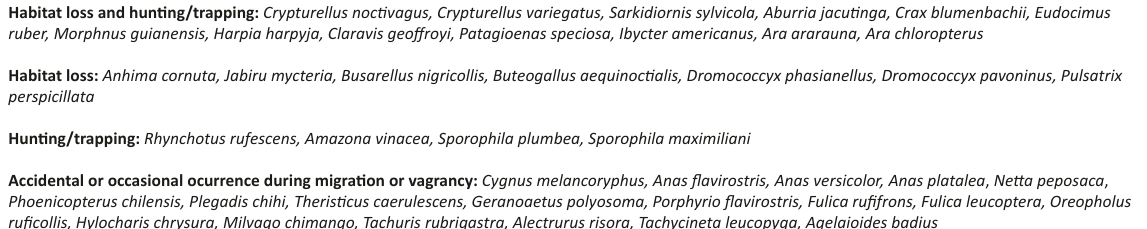
Table 5. Possible causes of local rarity for the rarest bird species in the state of Rio de Janeiro. Habitat loss and hunting/trapping: Crypturellus noctivagus, Crypturellus variegatus, Sarkidiornis sylvicola, Aburria jacutinga, Crax blumenbachii, Eudocimus ruber, Morphnus guianensis, Harpia harpyja, Claravis geoffroyi, Patagioenas speciosa, Ibycter americanus, Ara ararauna, Ara chloropterus Habitat loss: Anhima cornuta, Jabiru mycteria, Busarellus nigricollis, Buteogallus aequinoctialis, Dromococcyx phasianellus, Dromococcyx pavoninus, Pulsatrix perspicillata Hunting/trapping: Rhynchotus rufescens, Amazona vinacea, Sporophila plumbea, Sporophila